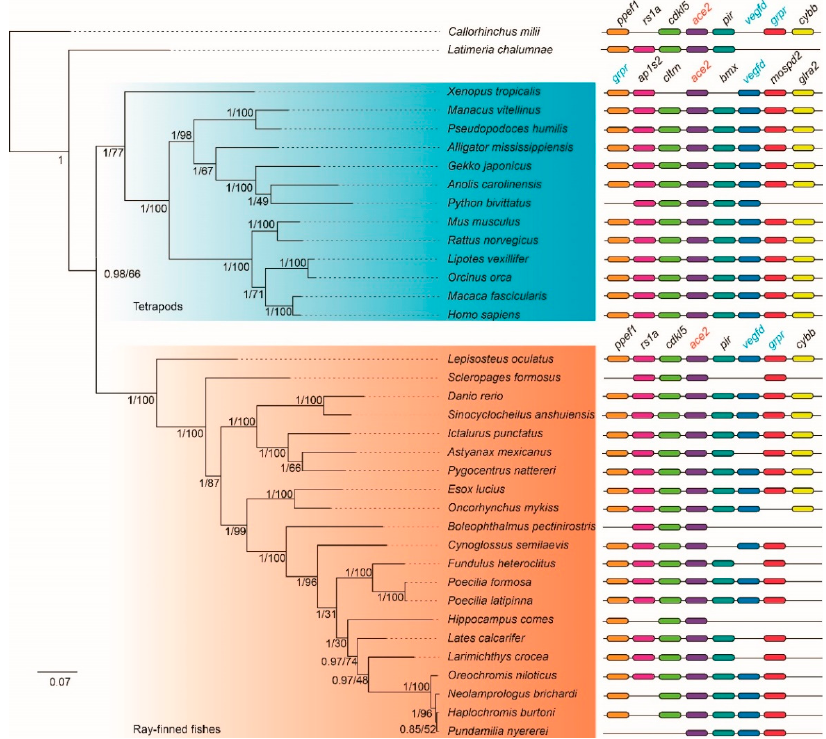
Figure 3. A phylogenetic tree based on 36 ace2 synteny sequences.